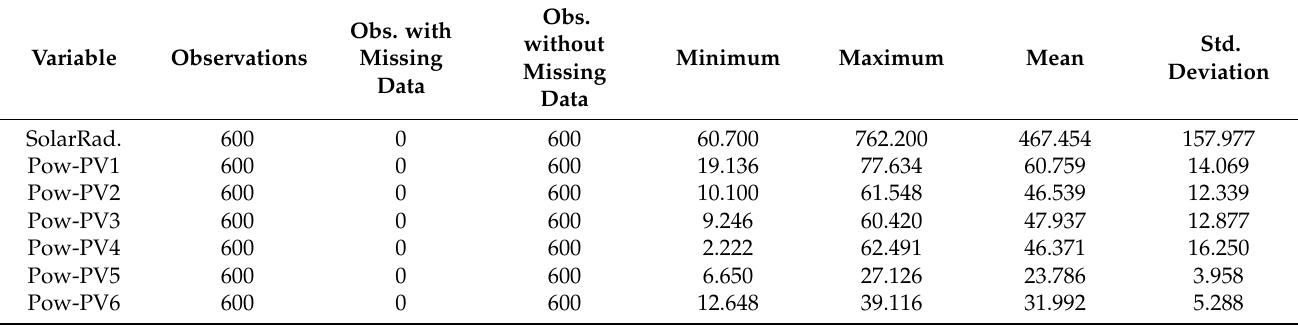
Table 5. The descriptive summary statistics of the experimental